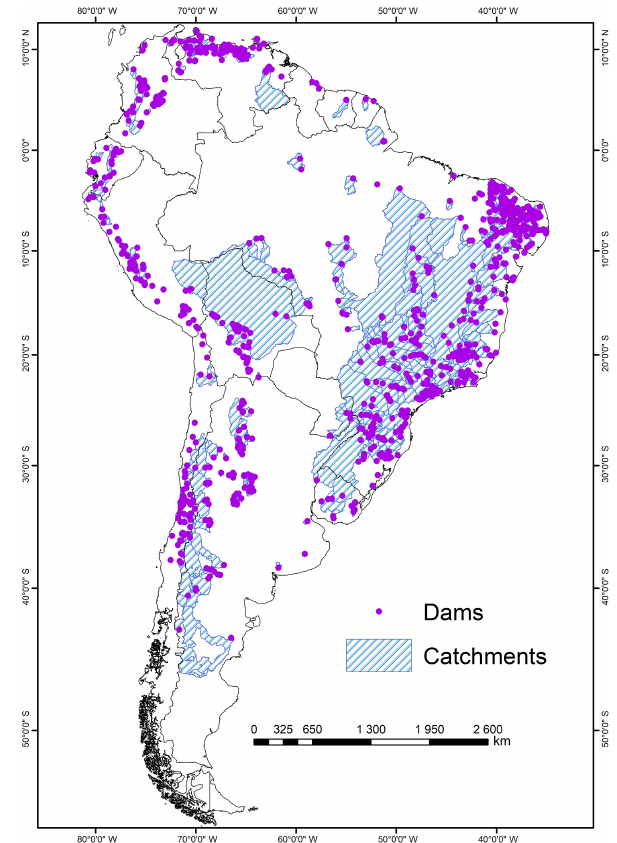
Figure 1. Dataset of Georeferenced Dams in South Amer- ica